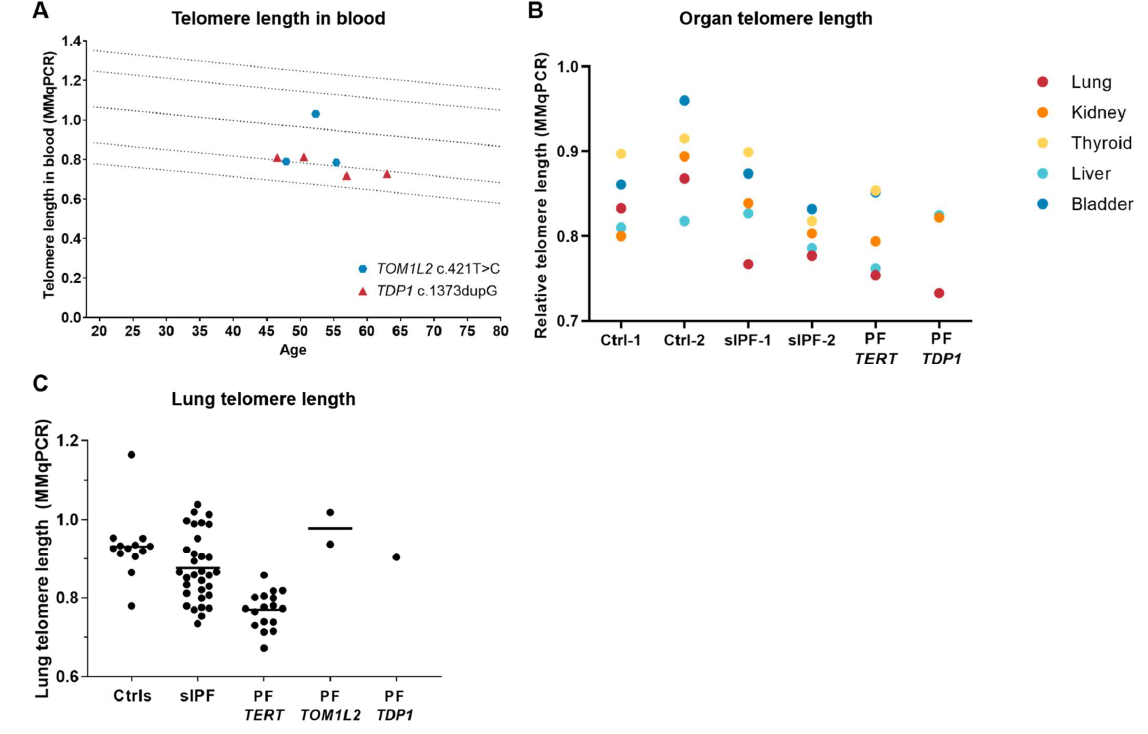
Figure 7. ( A ) Telomere length in blood plotted against age as measured by MMqPCR. Circles indicate patients carrying the TOM1L2 c.421T > C variant, triangles indicate patients carrying the TDP1 c.1373dupG variant. The straight line indicates 50th percentile of control subjects; dotted lines the 1st, 10th, 90th, and 99th percentile of control subjects. ( B ) Telomere length in autopsy FFPE tissue from different organs. PF TERT = PF patient with a mutation in the TERT gene; PF TDP1 = Patient 4; ( C ) Telomere length in biopsy tissue of whole lung. Data on controls, IPF, and TERT mutation carriers in ( B , C ) were previously published [4]. No statistical analysis was applied due to small group size.